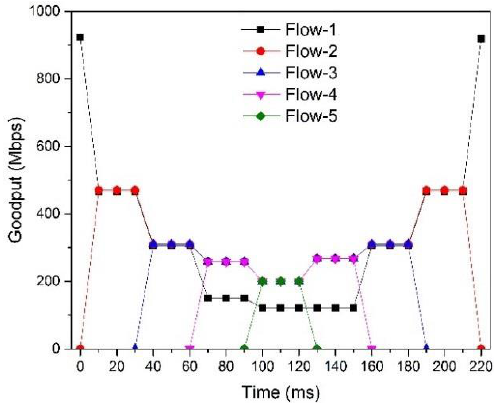
Figure 15. SDTCP fairness.